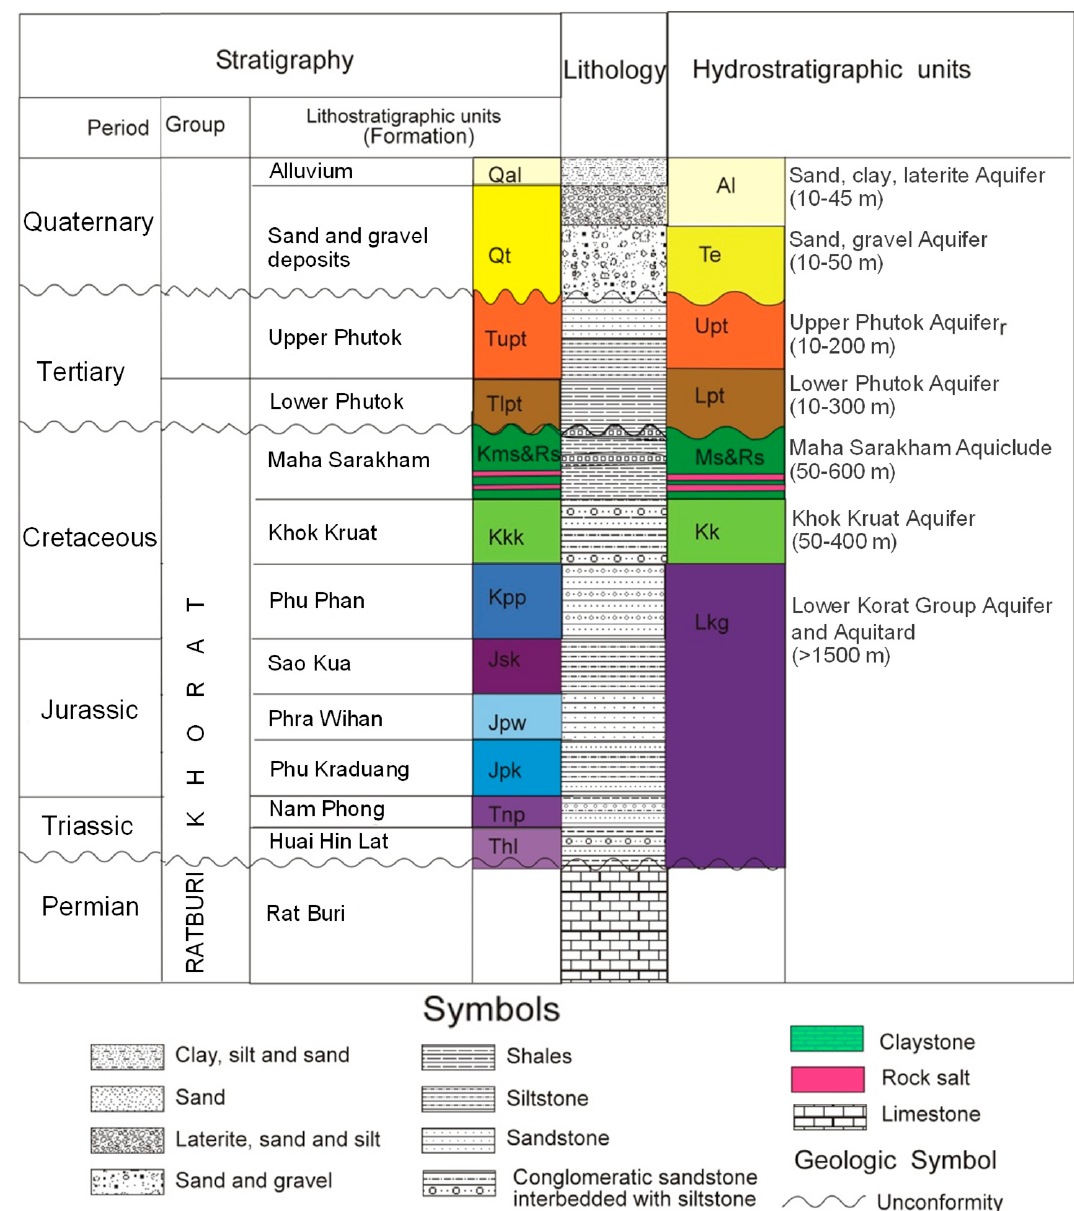
Figure 4. Hydrostratigraphic units of the CHLB (modified from [39]).